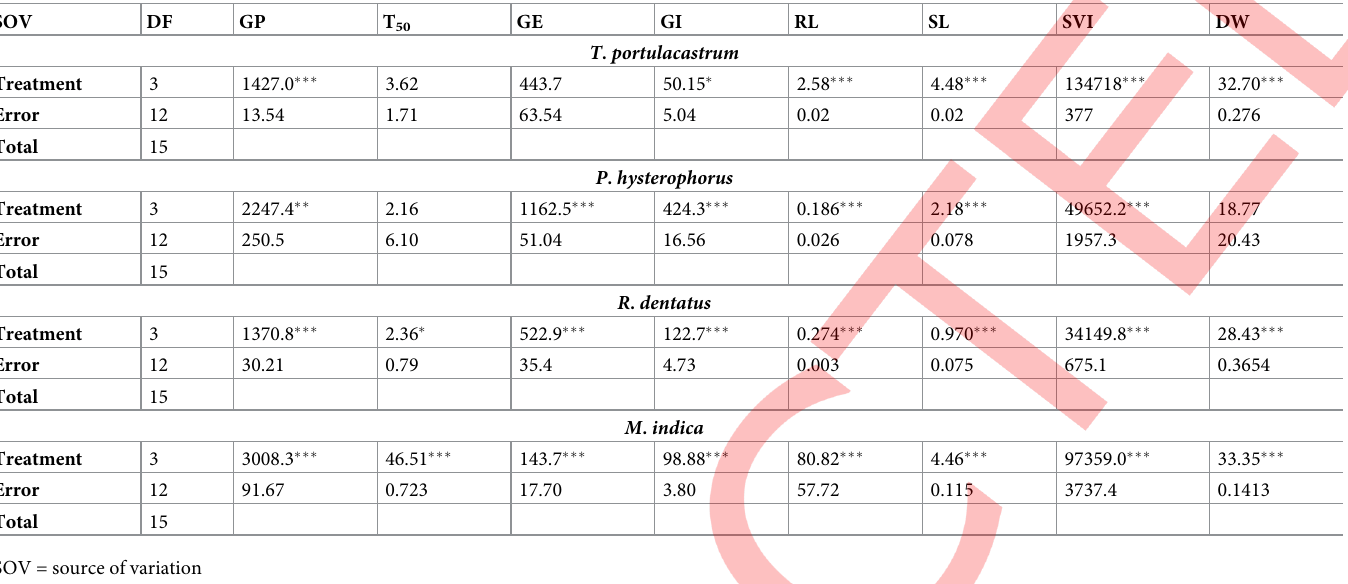
Table 1. Analysis of variance (mean squares) of phytotoxic effect of aqueous plant extracts of Fabaceous plants on germination and seedling growth of different broadleaved weed species. SOV